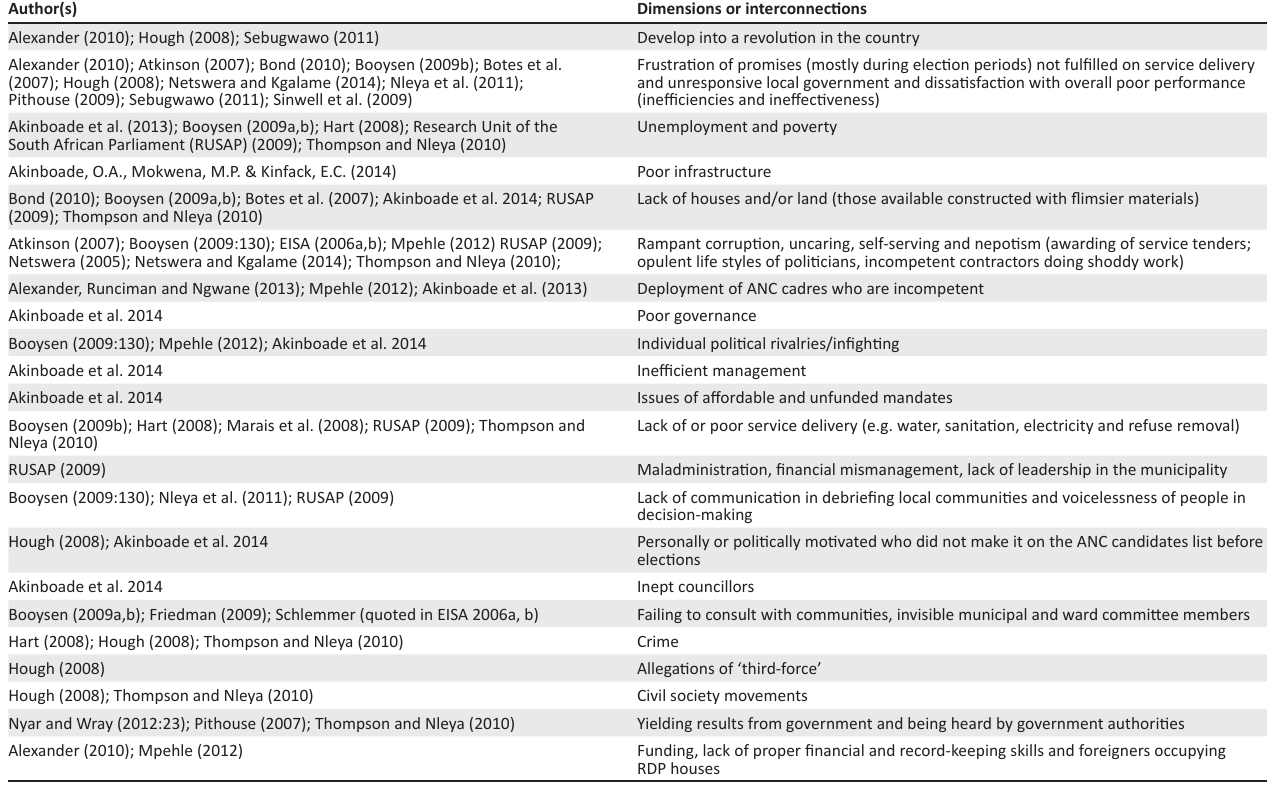
TABLE 1: Dominant dimensions and interconnections on service delivery